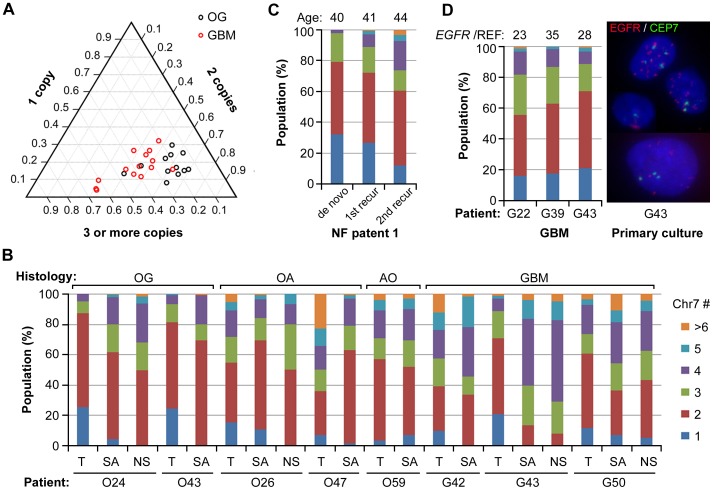
Proportion of cells with Chr7 number variation in high- and low-grade gliomas and glioma primary cultures.
A, ternary plot of population proportions with 1 copy (deletion), 2 copies (normal), and 3 or more (amplification) copies of Chr7, based on CEP7 signals in Ffuorescent in situ hybridization (FISH) of 14 glioblastoma multiformes (GBMs, Red triangle) and 12 oligodendroglial tumor (OGs, black square), P = 0.0012 from MANOVA analysis. B, comparison of tumor heterogeneity with regard to chromosome 7 (Chr7) aneuploidy in the original tumor (T) and corresponding 3–4 week-old primary cultures under serum adherent (SA) or neural sphere (NS) culture conditions. C–D, patterns of cells with Chr7-CNV in sequential and high-EGFR amplified GBMs. Representative FISH pictures of cells carrying 1–4 copies of Chr7 with focal EGFR amplification.